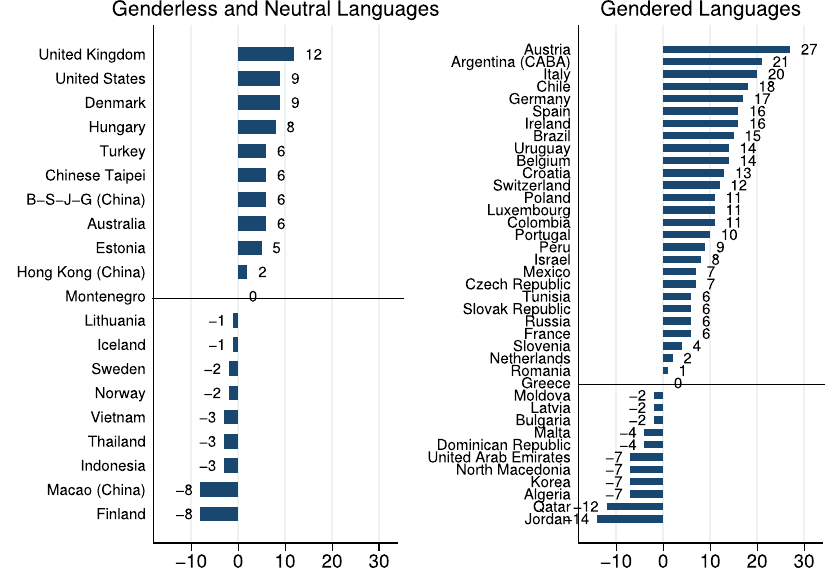
Fig. 1 The gender gap in mathematics by country and type of language, boys – girls (PISA, 2015). The 2015 data were collected by the Programme for International Student Assessment (PISA). PISA assesses the average gender gap in mathematics achievements for 15-year-olds in OECD and OECD partner countries. The data was merged with the dataset generated by Prewitt-Freilino et al. 3 that denotes whether the language spoken in a country is gendered genderless or gender neutral. The merged dataset includes 59 countries with an average gender gap in mathematics achievements of 4.71 (SD = 8.78). The PISA scores are scaled to fi t an approximately normal distribution with a mean around 500 score points and a standard deviation around 100 score points. Thus a 1 point difference on the PISA scale corresponds to an effect size (Cohen ’ s d ) of